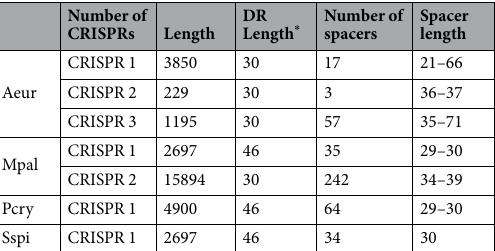
Table 2. Information of confirmed CRISPRs from Sphingobacteriaceae strains. * DR, direct repeats. Abbreviations for Sphingobacteriaceae strains are defined in Fig. 2